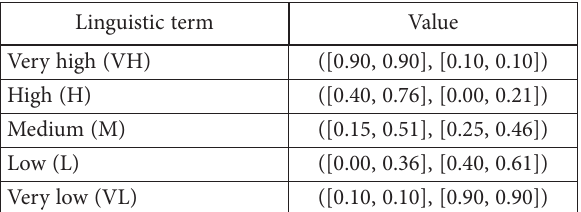
Table 2. Linguistic values for assessing the criteria Linguistic term